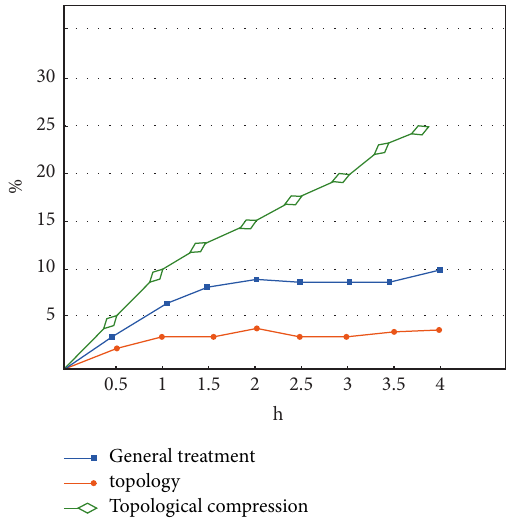
Figure 6: Comparison of processed data under three modes.